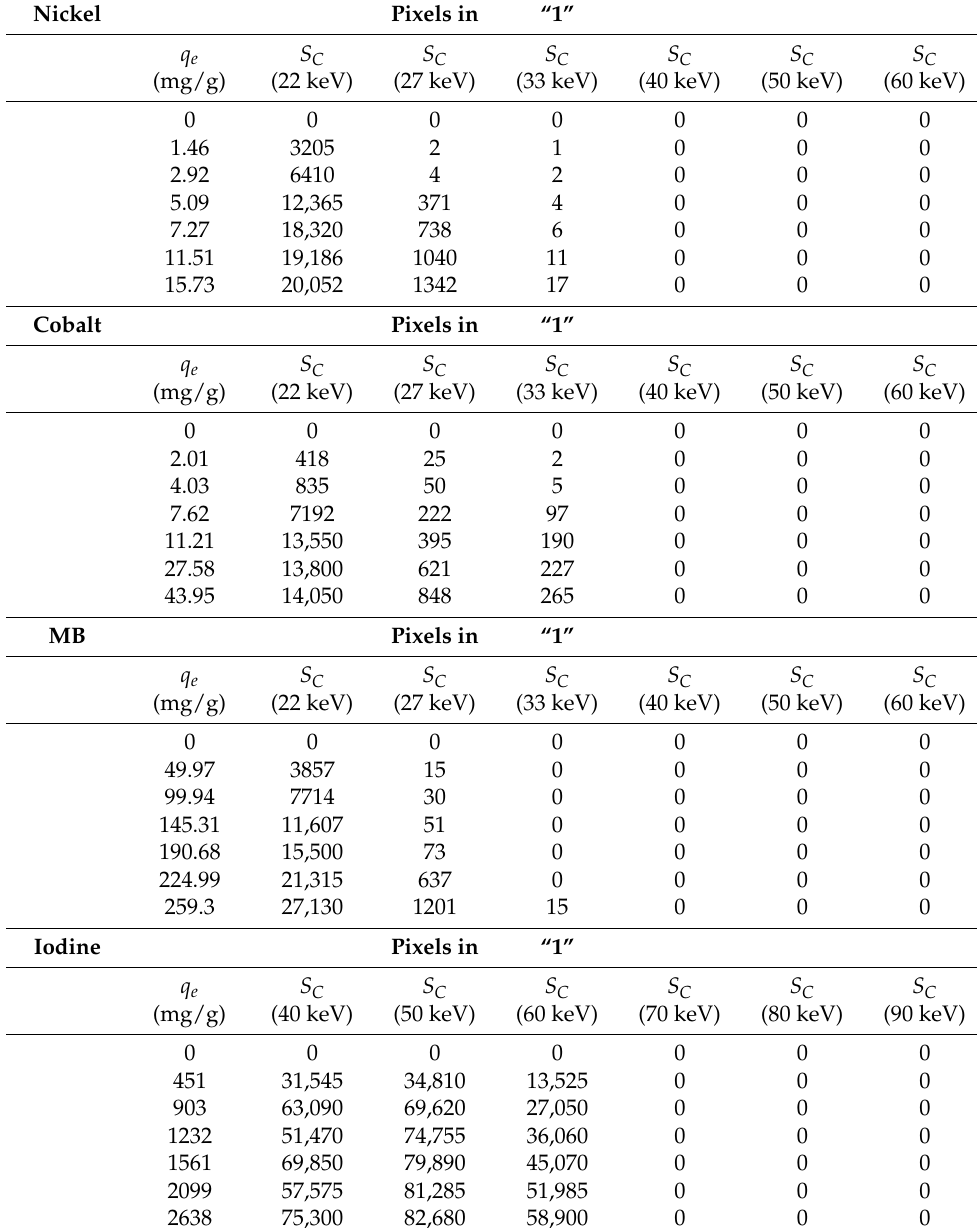
Table 7. q e and S C parameters found at different